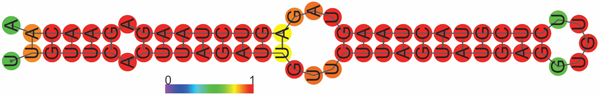
A typical hairpin-like secondary structure of a microRNAprecursor. This secondary structure was generated using the RNAfold secondary structure predictor of the Vienna RNA WebSuite on a known Arabidopsis microRNA precursor retrieved from the miRBase database [miRBase:MI0008304]. The color-code used represents the base-pair probabilities based on a minimum free energy analysis.